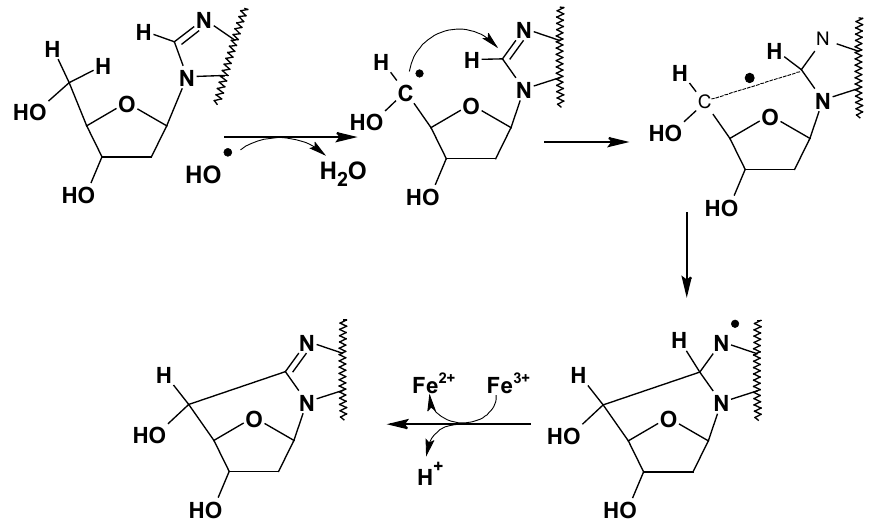
Figure 1. Formation of 5’,8-cyclopurine-2’-deoxynucleosides during the irradiation of the purine-2’-deoxynucleosides